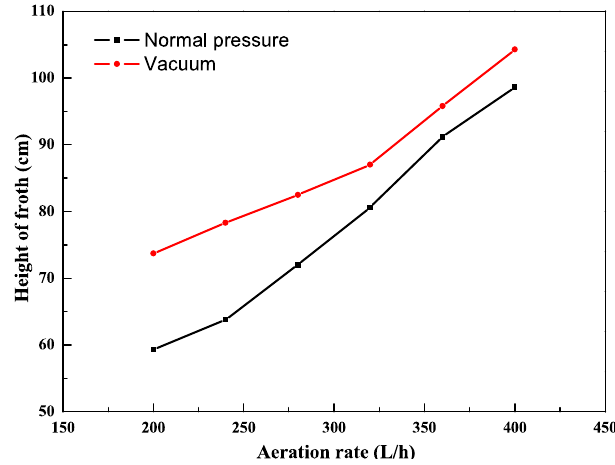
Figure 4. Effect of aeration rate volume and vacuum degree on the height of froth.